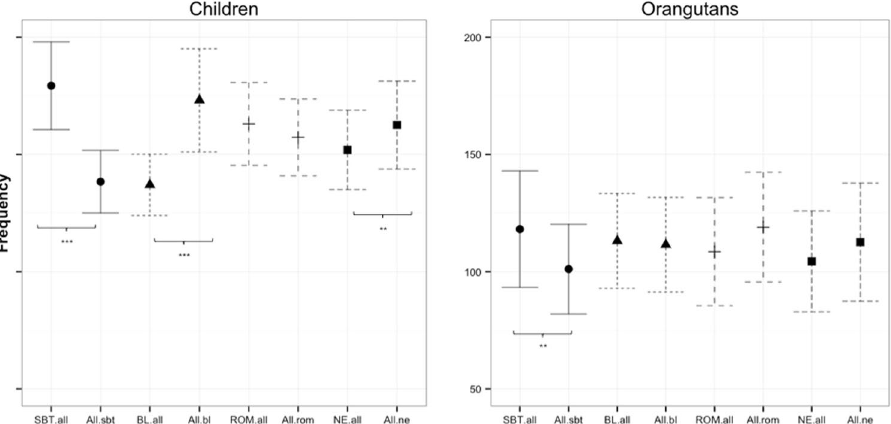
Figure 5. Fixation rates at orangutan facial expressions: Mean estimates of the fixation rates at the target emotion (either SBT (silent bared-teeth display), ROM (relaxed open mouth display), BL (bulging-lip display) and Neutral) compared to all corresponding distractors (e.g. “SBT.all” = SBT compared to ROM, BL and neutral) for human children and orangutans. The corresponding combinations (e.g., SBT.all and All.SBT) are depicted by the same symbols and lines. SBT: silent bared-teeth display; BL: bulging-lip display; ROM: relaxed open mouth display; NE: neutral. Significant comparisons are indicated by asterisks ( > 0.01 * ; > 0.05 ** ; > 0.01 *** ). Note that scales are identical for both